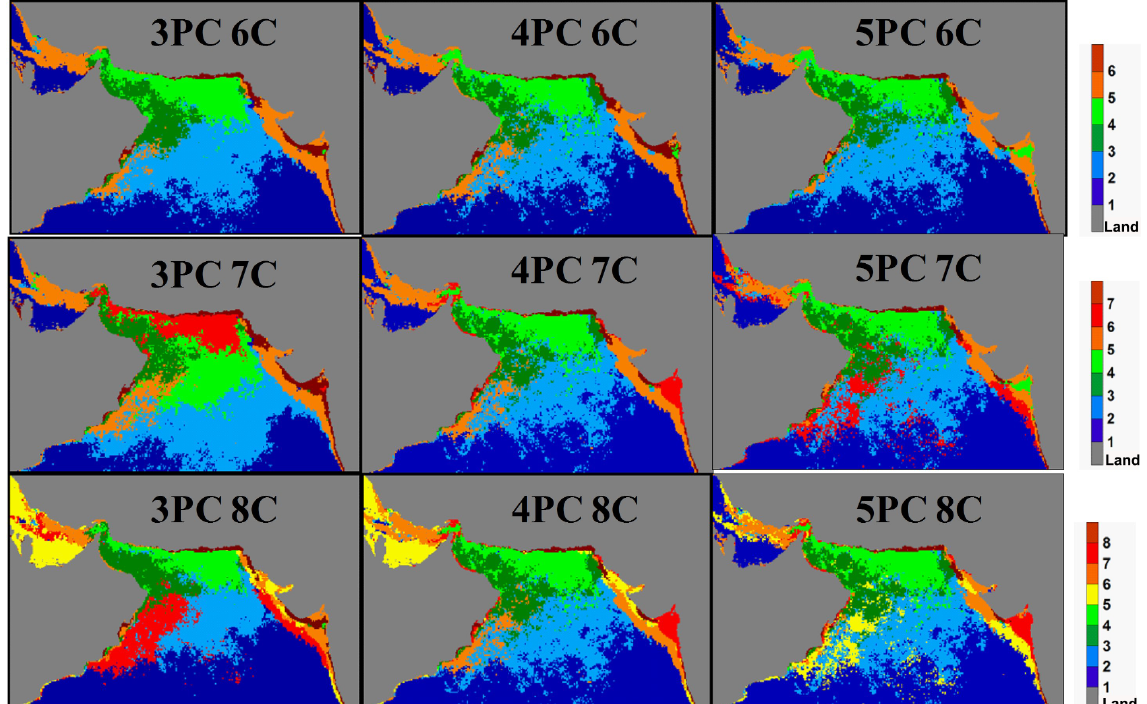
Figure A1. Various combinations of PC and CA tried out for achieving better